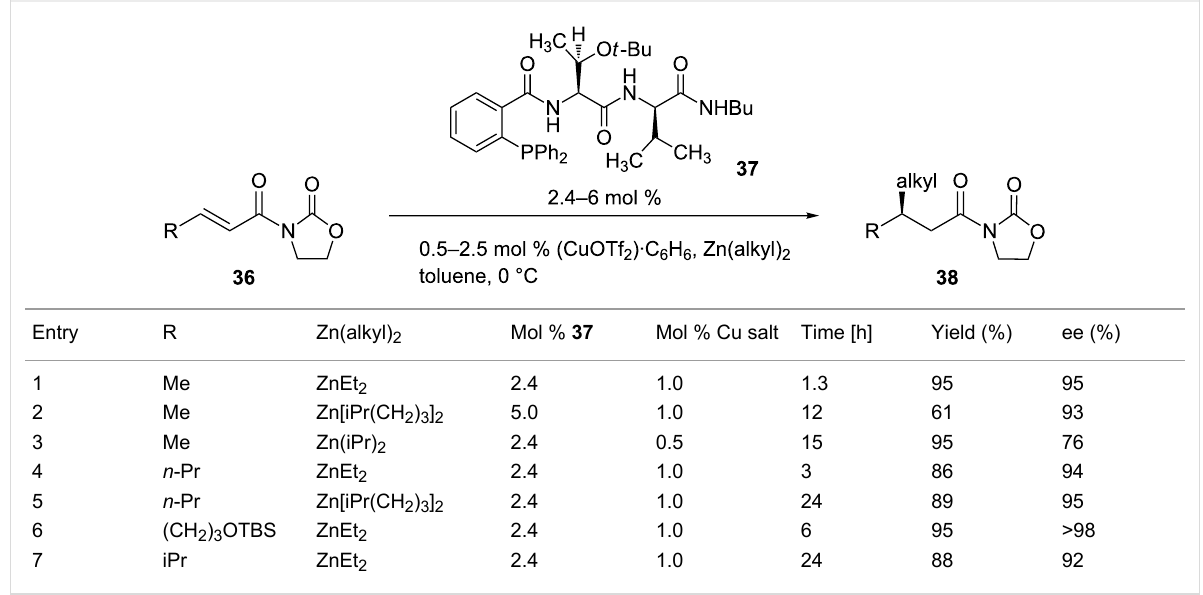
Table 4: Copper-catalyzed ECA of alkylzinc reagents to α , β -unsaturated N